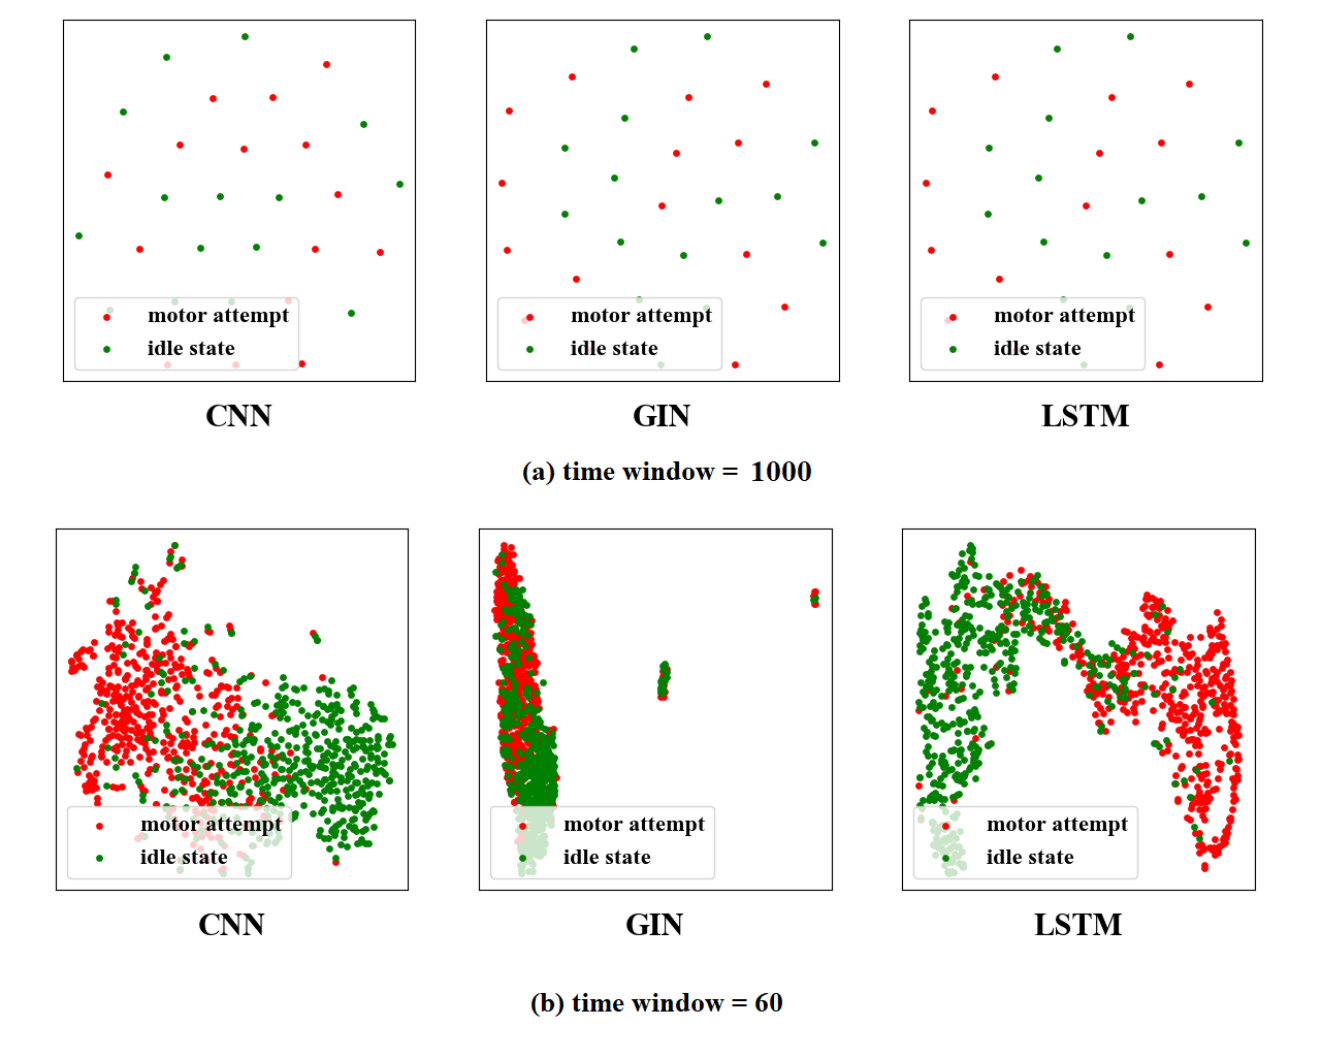
Figure 7. Feature visualization of different models for Subject 1. For time window ( a ), each scatter represents a feature extracted on one trail, and for time window ( b ), each scatter represents a feature extracted on one time window of one